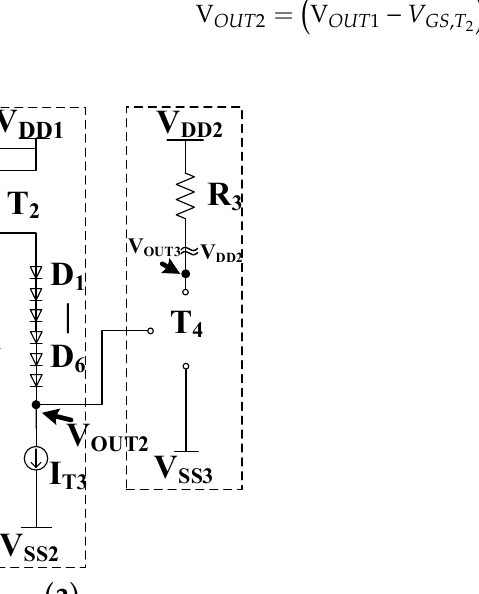
where W , L , µ n and C ox are the technology parameters. For the Schottky diodes D 1 -D 6 , each of them have the same voltage decrement, set to V D which is 2 V at 20 mA bias current, the total voltage decrement of the six diodes is 6 × VD. The magnitude of the voltage decrement can be controlled by adjusting the diameter of the diodes to get the proper V OUT2 (output of the 2nd stage) by